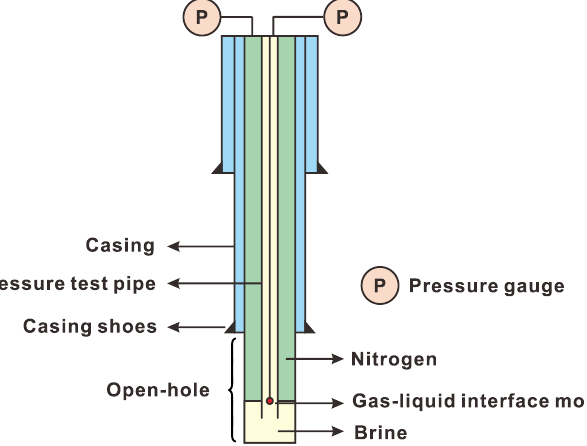
Figure 6. Schematic diagram of NLT method.